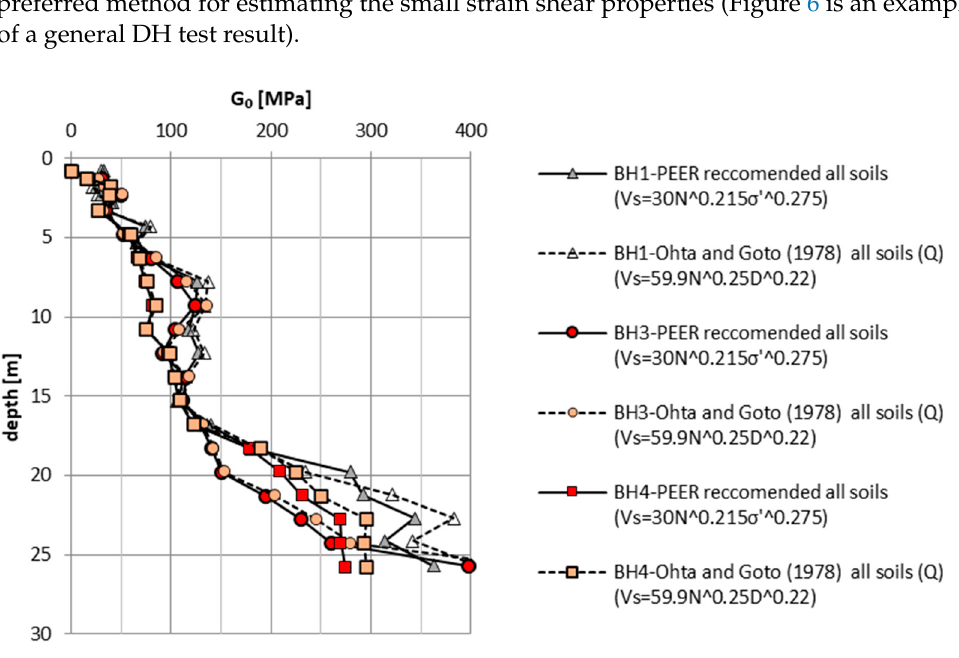
Figure 7. Top view of foundations.